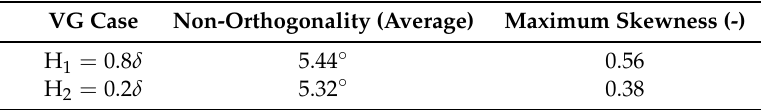
Table 2. Quality meshing parameters corresponding to the mesh of the two vane-type VG cases.